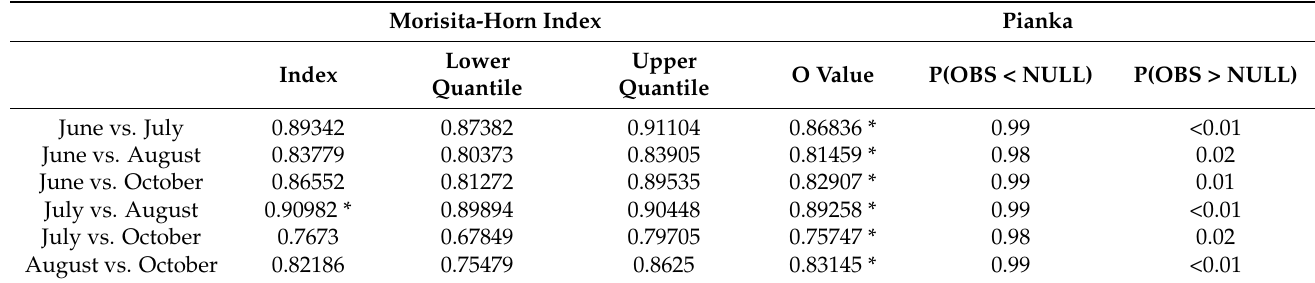
Table 2. Monthly pairwise comparisons of Eastern Box Turtle diet overlap using Morisita–Horn (M–H) indices and associated 95% Confidence Intervals, Pianka’s index of overlap (O), and the p values associated with O values. Both M–H and O vary from 0.0–1.0, with 0.0 indicating no dietary overlap, and 1.0 indicating complete dietary overlap.